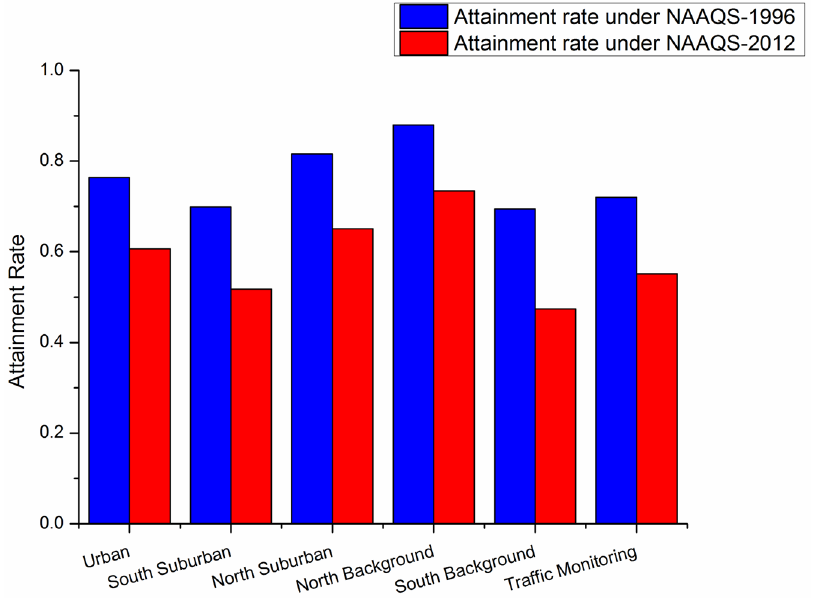
Figure 3. Annual AQI attainment rate of the six monitoring stations